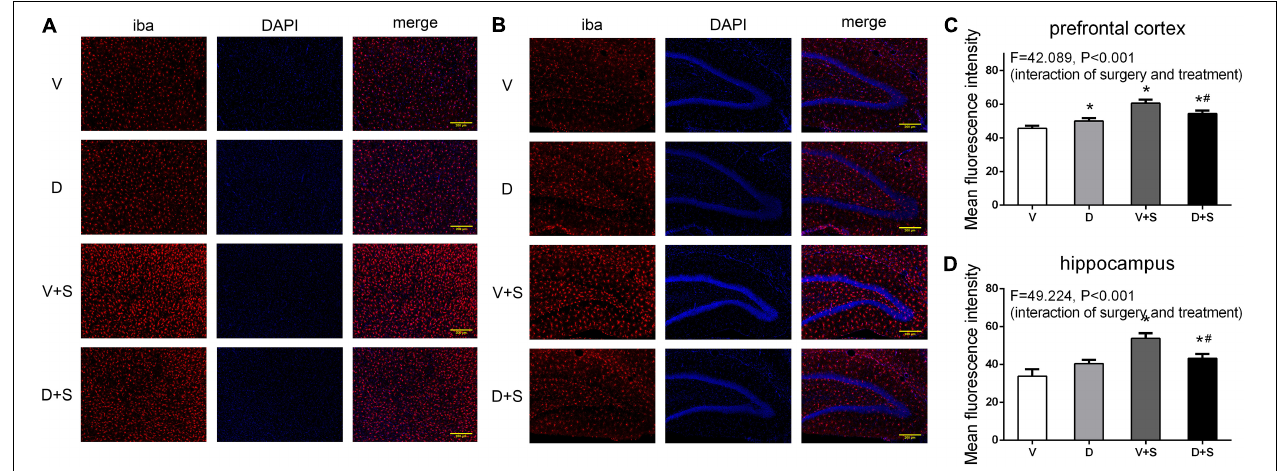
FIGURE 8 | DSP-4 treatment decreased the activation of microglia in surgical rats. The activation of microglia in the prefrontal cortex (A) and hippocampus (B) at 1 week postoperatively. (C,D) Mean fluorescence intensity in the prefrontal cortex and hippocampus at 1 week postoperatively. The data are presented as the means ± SEM for each group ( n = 3 per cohort). *Compared to Group V, # p < 0.05 compared to Group V + S.